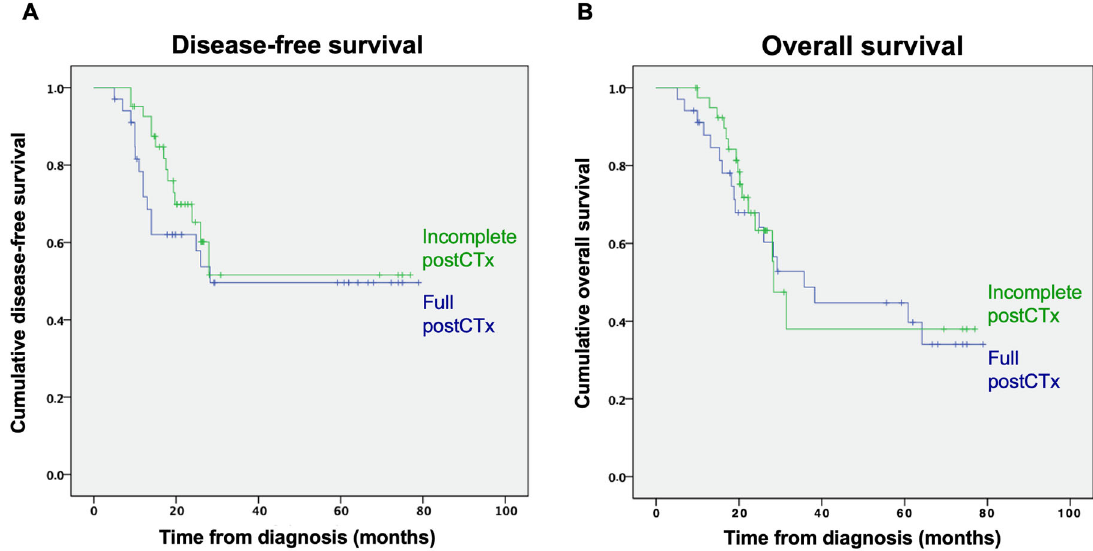
Figure 4. ( A ) Disease ‐ free and ( B ) overall survival by completeness of postoperative chemotherapy (postCTx). Full postCTx status is represented by blue lines. Green lines represent incomplete post ‐ CTx status.